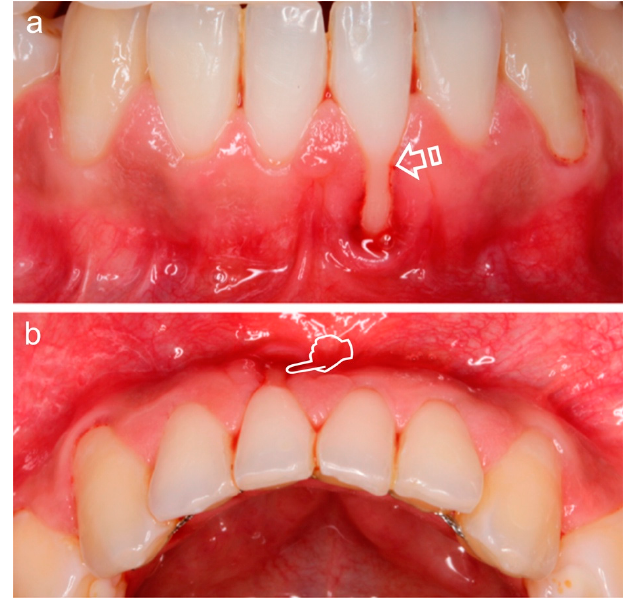
Figure 1. Miller Class II Gingival Recession Defect [7]. The gingival margin is located apical to the cementoenamel junction (CEJ) (arrow), resulting in exposure of the root surface. Frontal ( a ) and occlusal ( b ) vision. The loss of volume (pointer) is better appreciated in ( b ). Polymers 2020 , 12 , x FOR PEER REVIEW